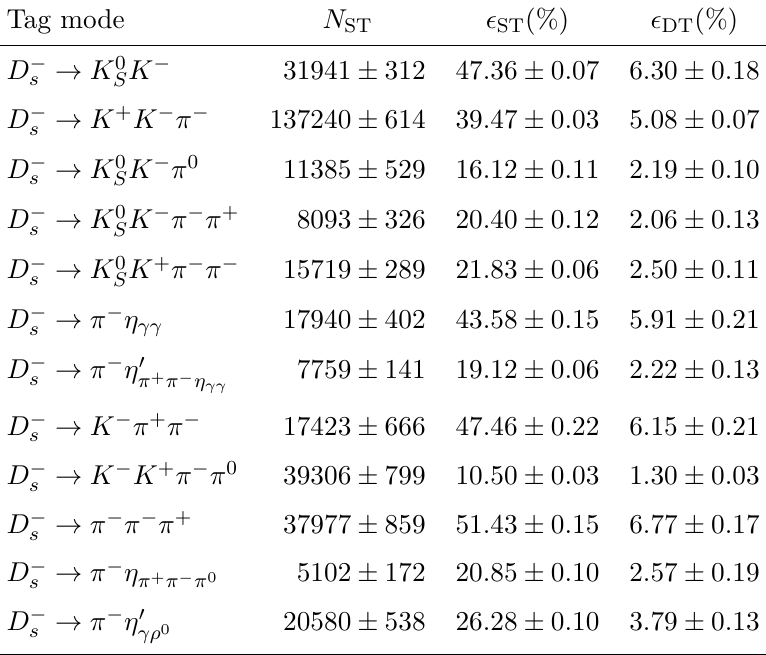
√ s = 4 . 178 GeV. The uncertainties are statistical.